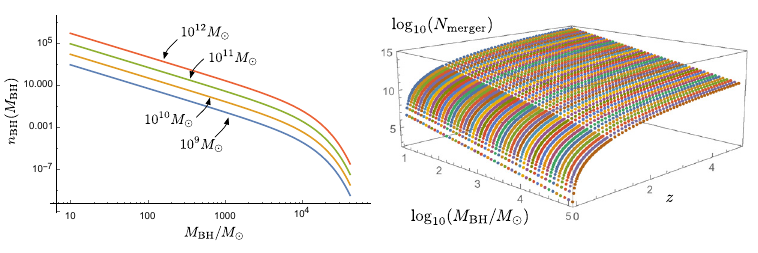
Figure 2. (left) Number density of BHs per galaxy as a function of BH mass for di ff erent total mass of = 10 9 M galaxies M –10 12 M . galaxy ⊙ ⊙ (right) Cumulative distribution function of the number of BH mergers N ( M ) as a function of merger BH the redshift z . We express number with binned one, of which we binned 20 for one order in M BH